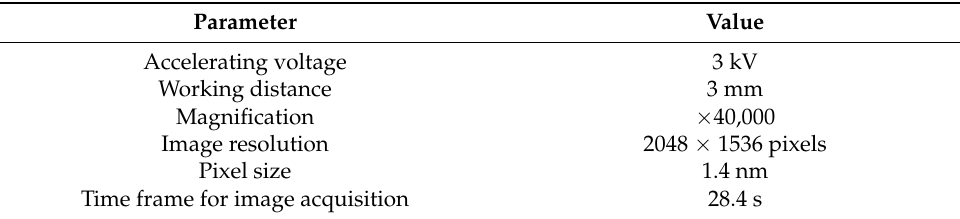
Table 2. Setup parameters used for SEM imaging.